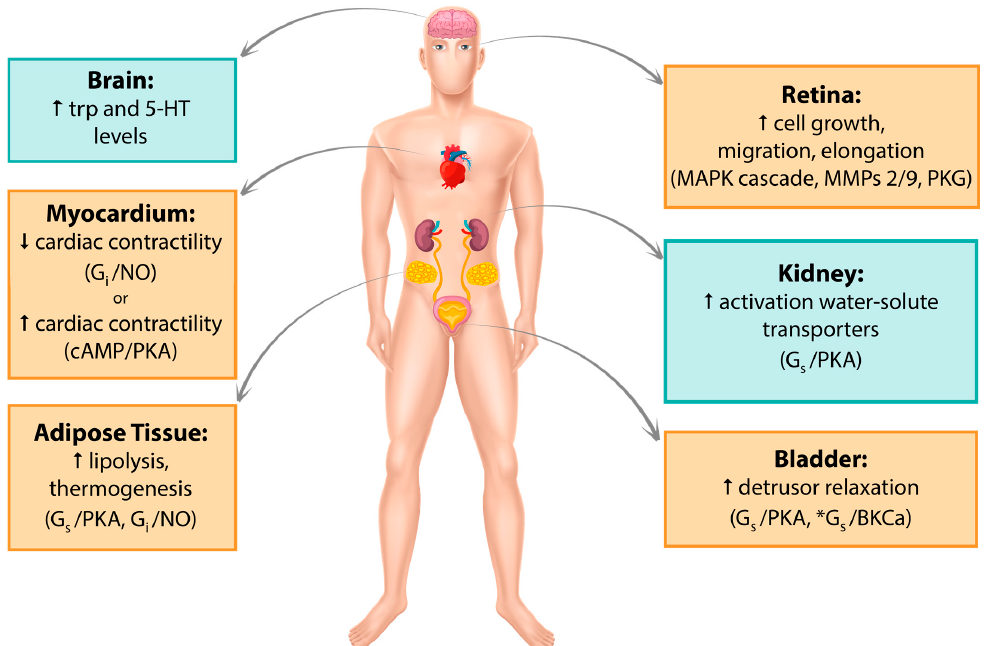
Figure 1. Graphic summary of β 3 -AR localization. Pathways that have been studied and reported in human tissue / cell lines are in yellow boxes. Pathways studied in mouse but not yet found in humans are in blue boxes. *Alternative cAMP-independent pathway. Trp, tryptophan; 5-HT, 5-hydroxytryptamine; MAPK, mitogen-activated protein kinase; MMPs, metalloproteinases, PKG, protein kinase G; NO, nitric oxide; PKA, protein kinase A.